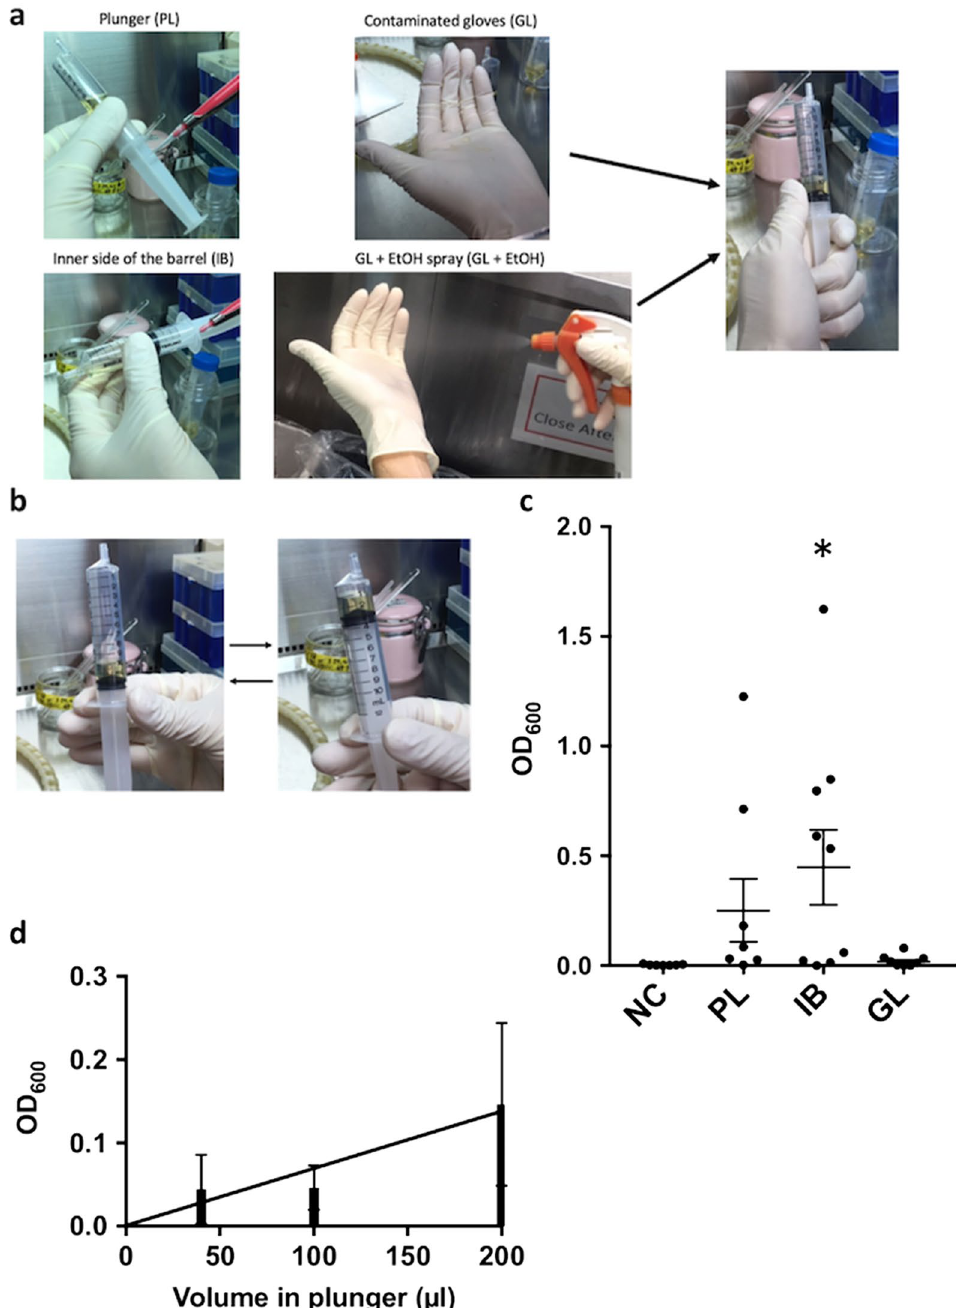
Figure 2. Pumping infusion with a syringe caused intraluminal contamination. ( a ) Representative images of each type of contamination and procedure. For the GL + EtOH condition, contaminated gloves were exposed to 80% ethanol spray and dried in the cabinet for a few minutes. ( b ) Each PIS was performed as follows: a plunger was moved between “3 and 12 mL” marks in one stroke and 2 s, 10 strokes were performed in total, and then the intraluminal medium present in the syringe was transferred into a sterile test tube. ( c ) Comparison between different types of contamination in PIS. Values are expressed as mean ± SEM, n = 9, * p < 0.05, ANOVA post-hoc Dunnett’s multiple comparison test. ( d ) Intraluminal contamination in a plastic syringe. Each volume of DH-5 alpha-containing medium was applied on a plunger, and PIS was performed. The absorbance values almost proportionally increased and fitted to the Y = 0.0007 × X + 0.0009 equation, with R 2 = 0.9254. Values are expressed as mean ± SEM, n =